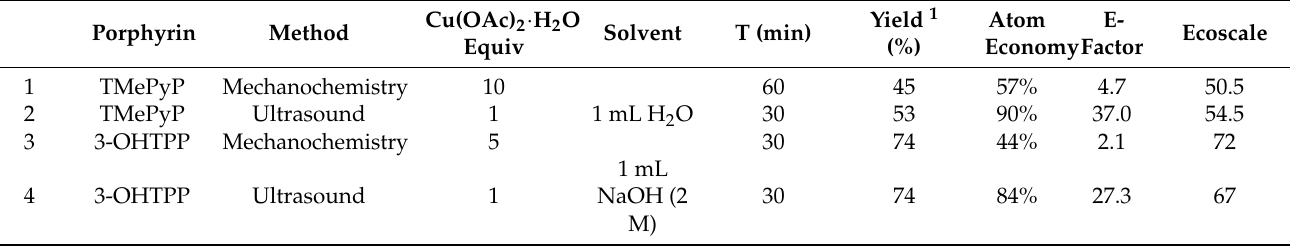
Table 5. Sustainability